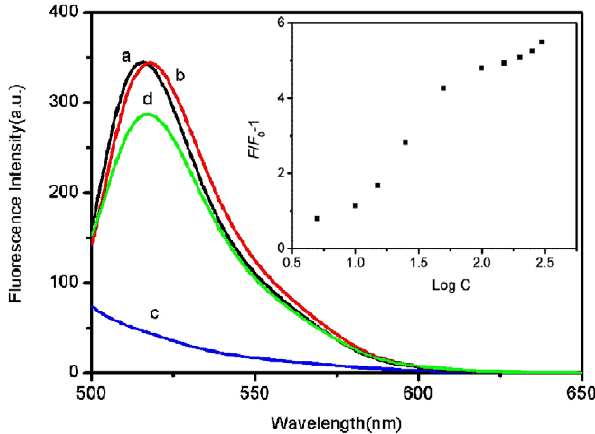
Figure 2. Performance of target DNA detection. Fluorescence emission spectra of P HIV (50 nM) at different conditions: (a) P HIV ; (b) P HIV + 300 nM T 1 ; (c) P HIV + RCPNs; (d) P HIV + RCPNs + 300 nM T 1 . Inset: fluorescence intensity ratio of P HIV -RCPN complex with F / F 0 –1 ( F 0 and F are the fluorescence intensity without and with the presence of T 1 , respectively) plotted against the logarithm of the concentration of T 1 (nM). Excitation was at 480 nm, and the emission was monitored at 518 nm. All measurements were done in Tris-HCl buffer in the presence of 15 mM Mg 2 + (pH: 7.4).